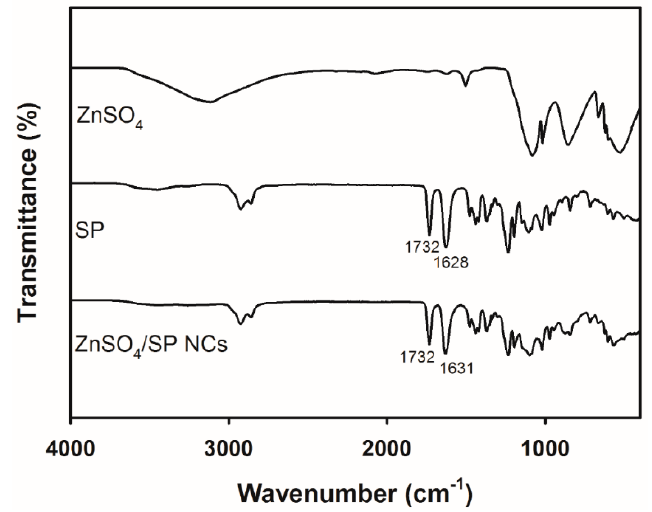
Figure 5. FT-IR spectra of ZnSO 4 , SP, and ZnSO 4 /SP NCs. Transmittance according to the wavenumber is shown.